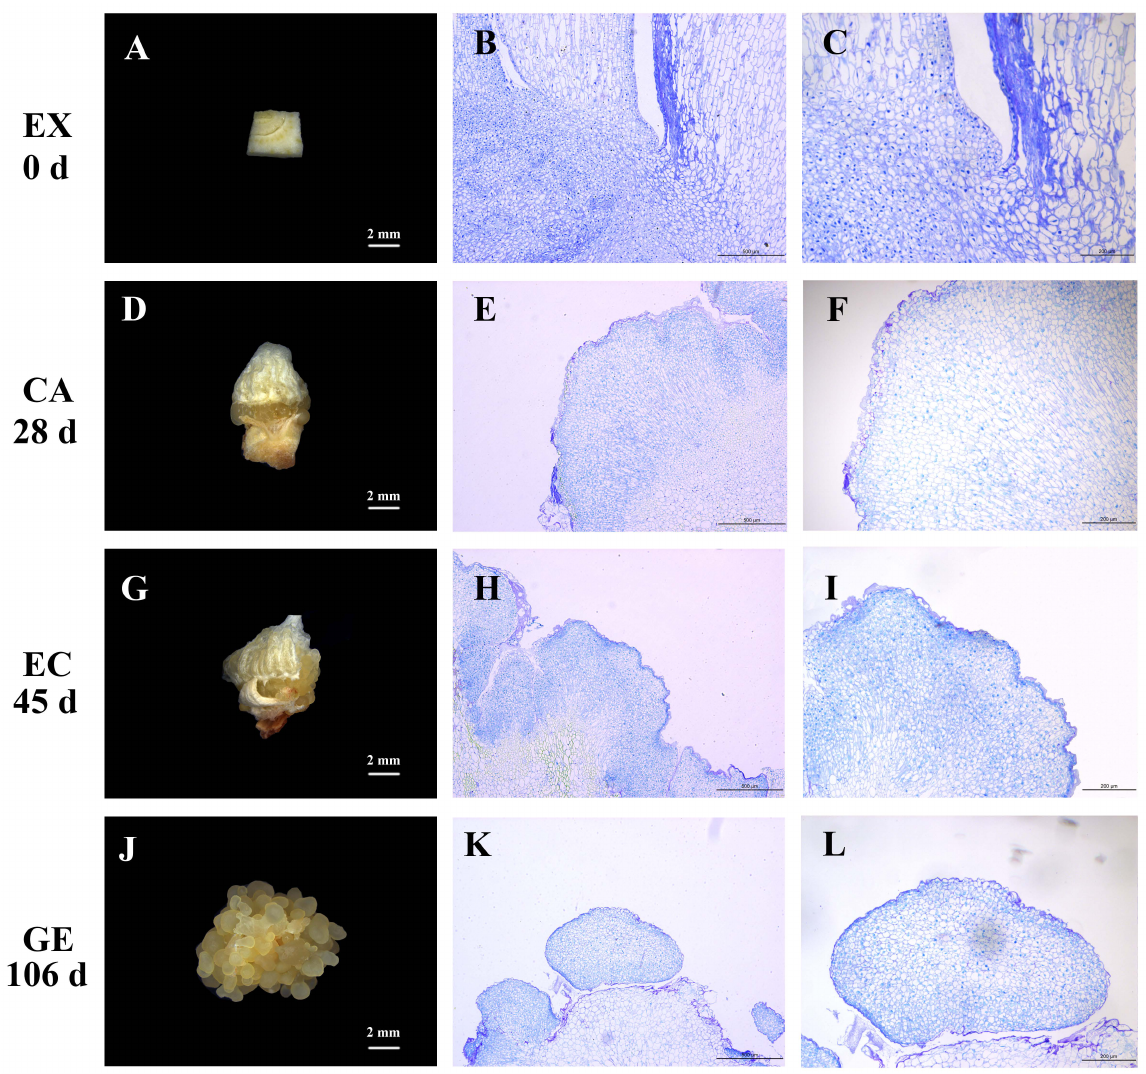
Figure 1. Morphologicalandhistologicalobservationatdifferentstagesofsomaticembryoinductioningarlic. Explants ( A ); paraffin sections of explants ( B , C ); callus ( D ); paraffin sections of callus ( E , F ); embryogenic embryos ( K , L ). EX, CA, EC, and GE on the left side indicated different sampling